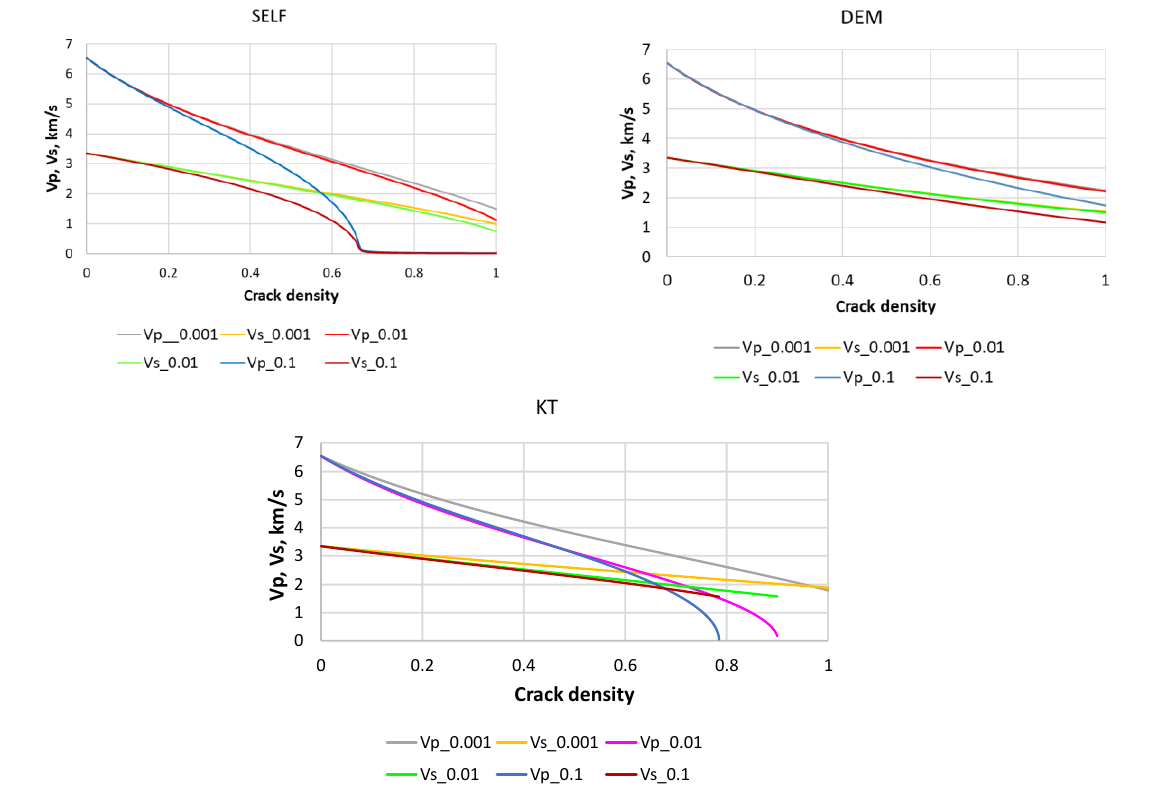
Figure 10. Elastic wave velocities as a function of crack density for isotropic model of a calcite matrix with randomly oriented cracks of various shapes. The numbers in the legend correspond to the aspect ratio of cracks. SCA is the self-consistent method, DEM is the differential scheme, and KT is the Kuster–Toksöz method.